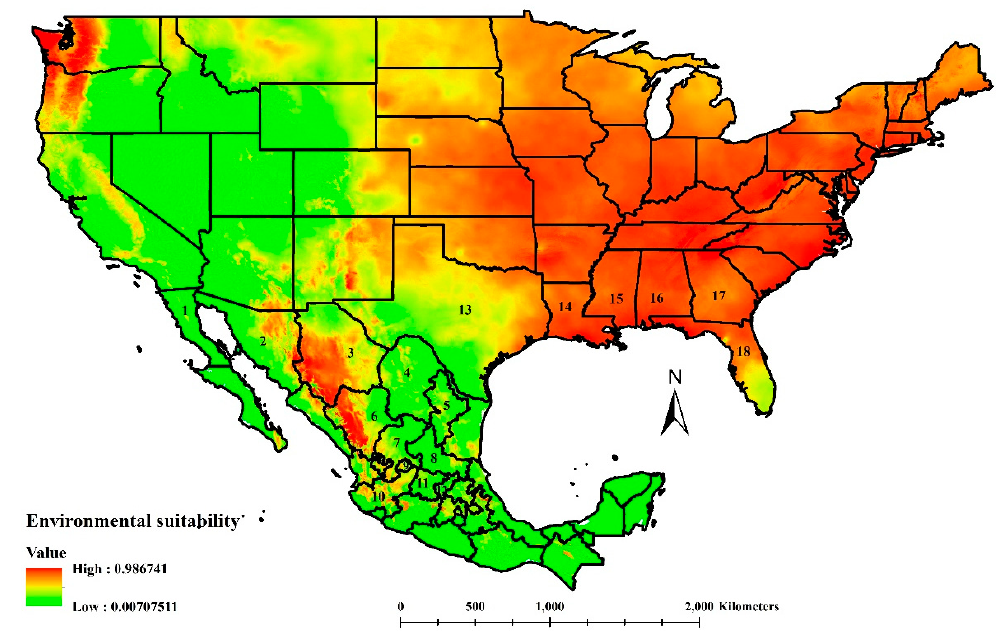
Figure 3. Environmental suitability for Apanteles opuntiarum , a parasitoid of Cactoblastis cactorum in North America according to the division by states for Mexico and the United States. State identifications for Mexico includes (1) Baja California, (2) Sonora, (3) Chihuahua, (4) Coahuila, (5) Nuevo Leon, (6) Durango, (7) Zacatecas, (8) San Luis Potosi, (9) Aguascalientes, (10) Jalisco, (11) Guanajuato, and (12) Queretaro. State identifications for the United States includes (13) Texas, (14) Louisiana, (15) Mississippi, (16) Alabama, (17) Georgia, and (18) Florida. As the environmental suitability level moved towards the red end of the scale, a more significant environmental suitability for A. opuntiarum was calculated.